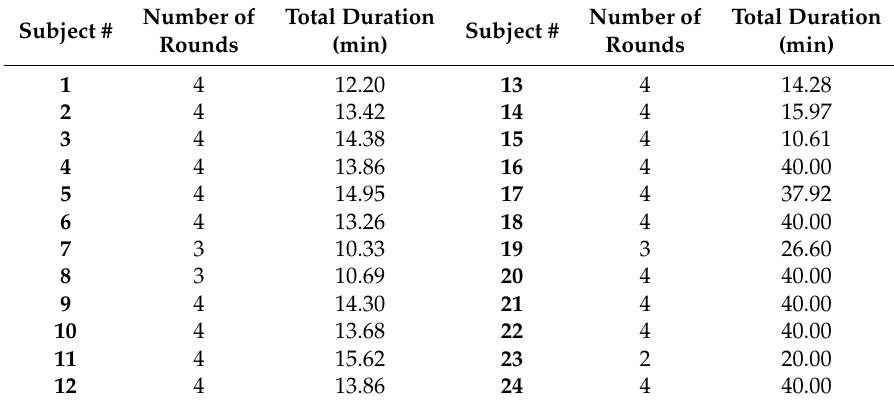
Table 1. Number of rounds and total duration of the movement data used for each subject.